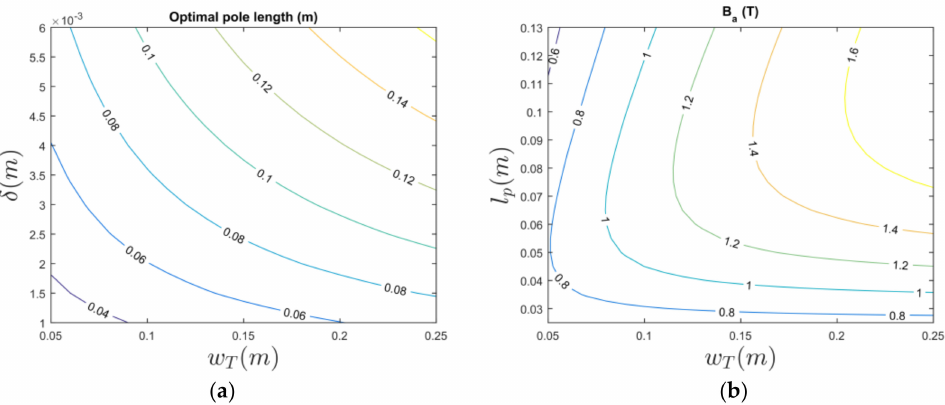
Figure 3. Contour plots of the optimal pole length from Equation (14) vs. δ and w T ( a ), and contour plots of B a from (13) vs. l p and w T ( b ). Values k = 0.45 and µ r , m = 1.1 are used, and in ( b ) δ = 0.003